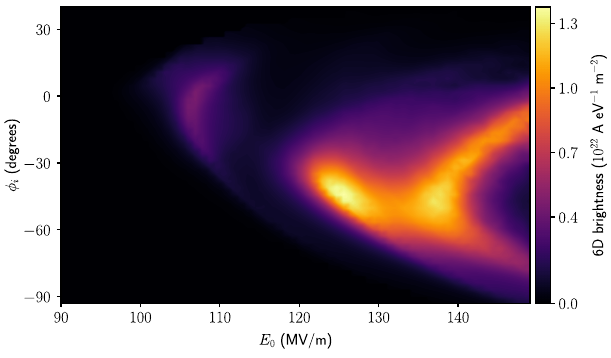
FIG. 5. The final beam brightness B 6 D ¼ Q over ( ϕ , E 0 ). The maxima correspond very closely with minimum bunch lengths but differentiations arise from charge losses and, e.g., beam